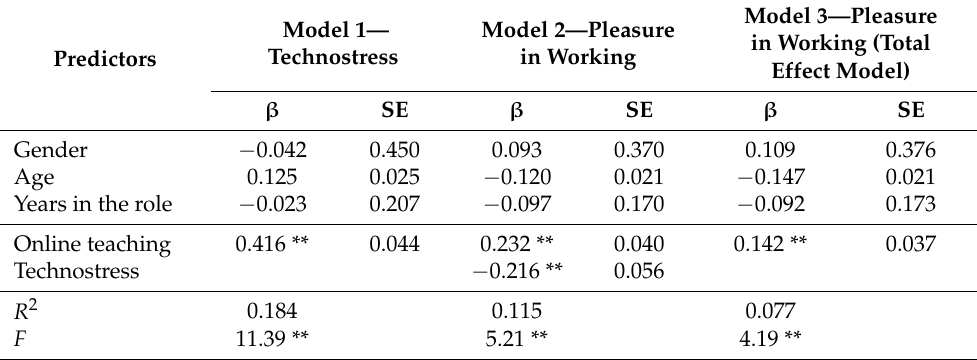
Table 2. Mediation effect of technostress in the relationship between online teaching and pleasure in working (N =